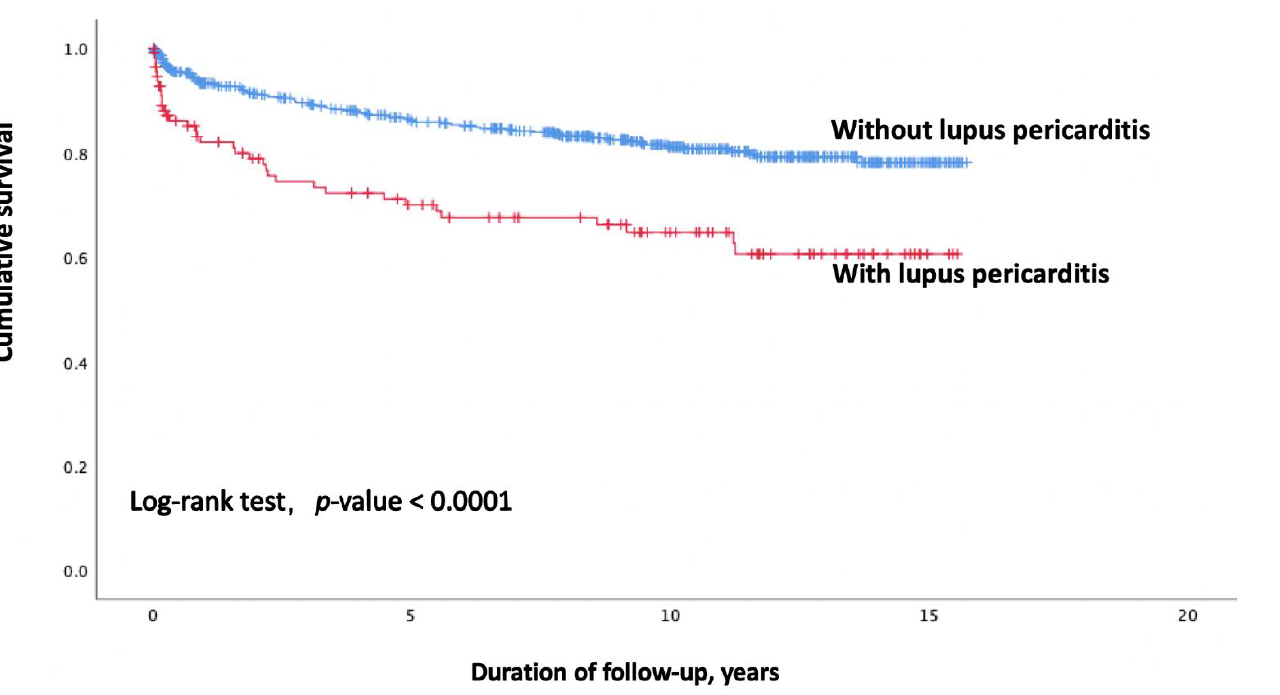
Figure 1. Survival curves of SLE patients with and without lupus pericarditis. Abbreviations: SLE, systemic lupus erythematosus.